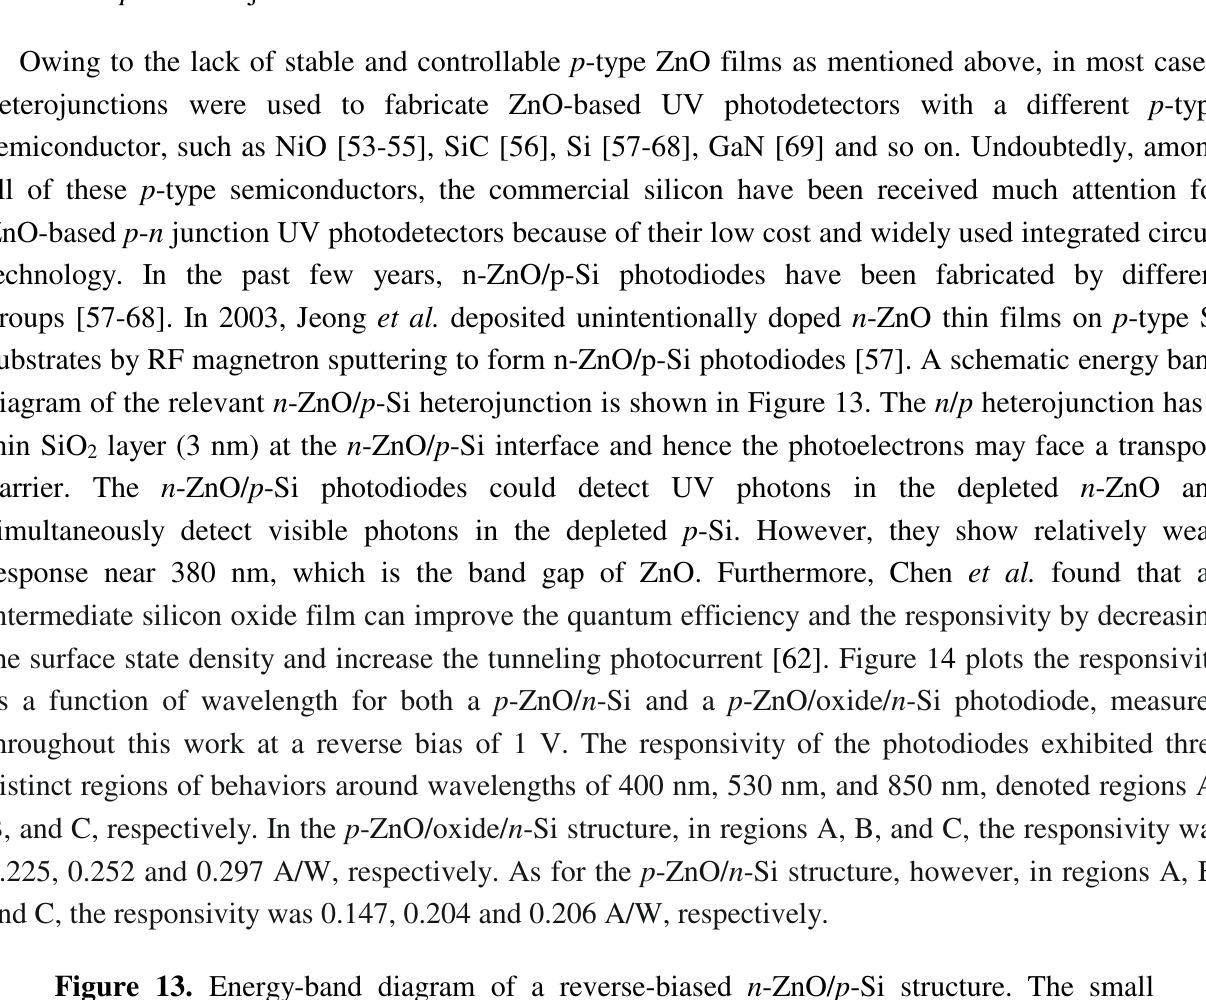
Figure 13. Energy-band diagram of a reverse-biased n -ZnO/ p -Si structure. The small drawing is an illustration showing carrier transports in the depleted n -ZnO under UV illumination